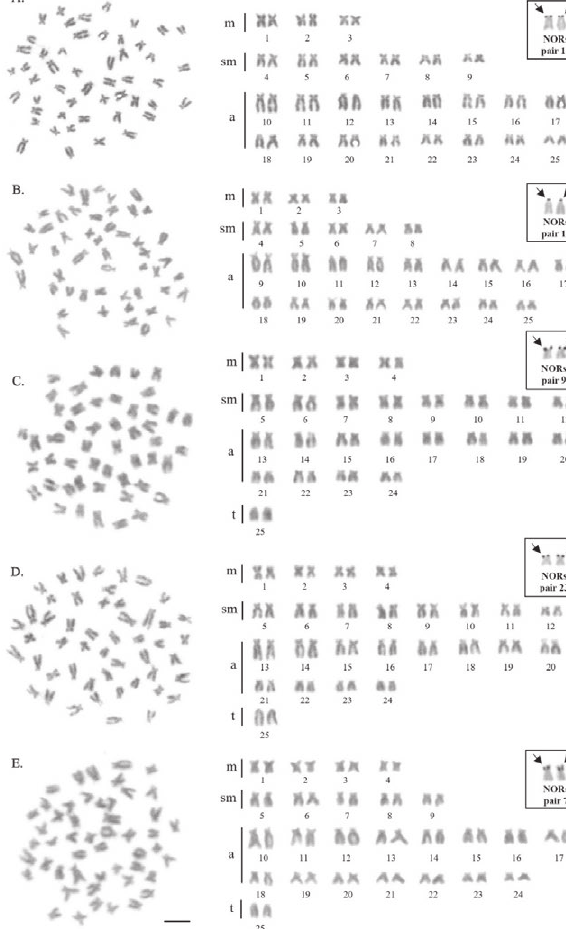
Figure 2. Metaphase chromosome plates and karyotypes of the Devario regina (A.) , D. laoensis (B.), Rasbora paviana (C.) , R. auro- taenia (D.) and Esomus metalicus (E.), by conventional staining. The arrows indicate NOR banding by Ag-NOR staining technique (inserted box). All species share the karyotype composed of 50 chromosomes. Scale bar indicates 5